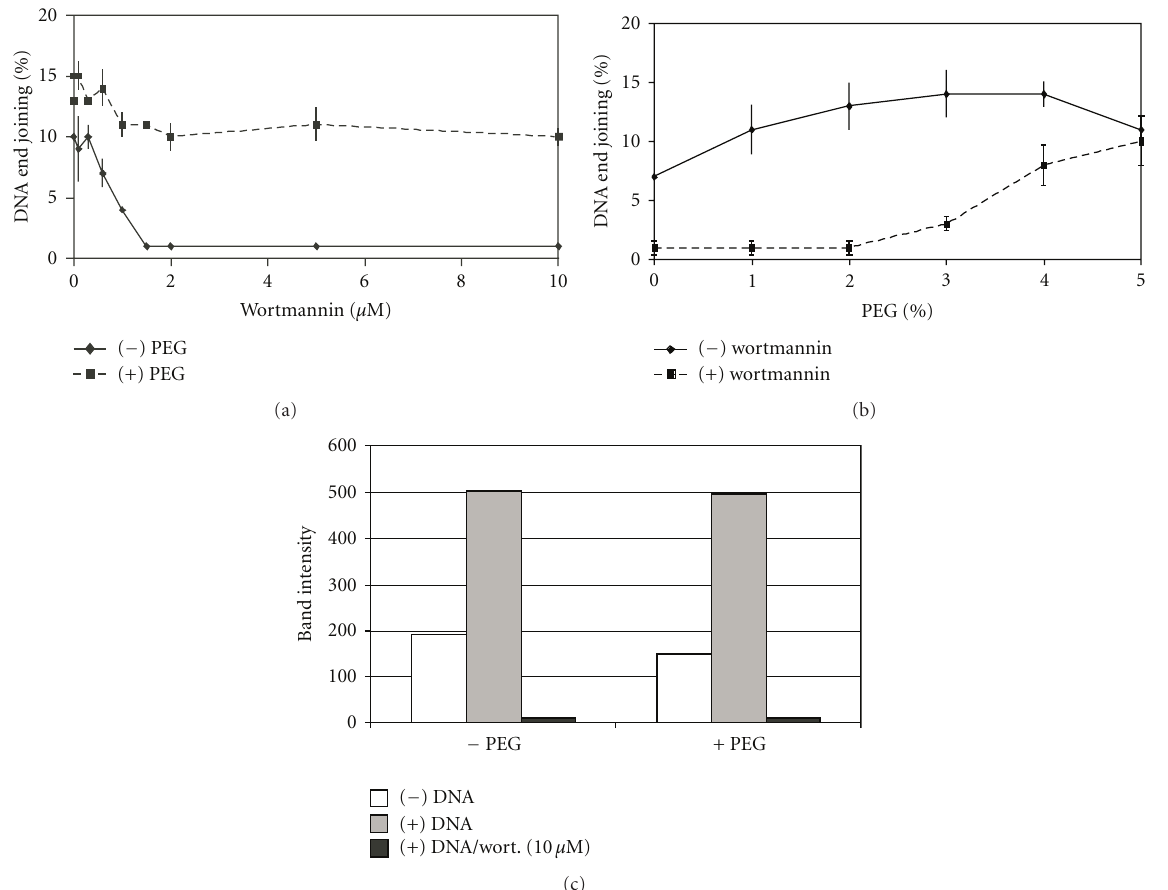
Figure 2: DNA end-joining activity and DNA-PK activity responses in PEG and/or wortmannin. (a) Wortmannin dose response. DNA end- joining reactions were run using HeLa WCE under standard conditions with or without 5% PEG and wortmannin for 1 hr at 30 ◦ C. Reactions contained 0 to 10 μ M wortmannin in 1% DMSO. Error bars indicate the standard deviation for triplicate reactions. (b) PEG dependence of wortmannin sensitivity. DNA end-joining reactions were run in triplicate with and without 10 μ M wortmannin at 0–5% PEG. (c) DNA-PK kinase activity under DNA end-joining reaction conditions in the presence and absence of PEG. Standard DNA end-joining reactions were run with HeLa WCE for 10 min at 30 ◦ C in the presence of a DNA-PK peptide substrate and [ γ - 32 P] ATP. The peptide was isolated on a 16% PAGE gel and the intensity of the radiolabeled band, a measure of DNA-PK kinase activity, was detected by autoradiography. The presence or absence of 5% PEG during the end-joining reaction did not a ff ect DNA-PK kinase activity, nor did it a ff ect the ability of wortmannin to inhibit DNA-PK kinase activity. The mean activity of duplicate reactions is